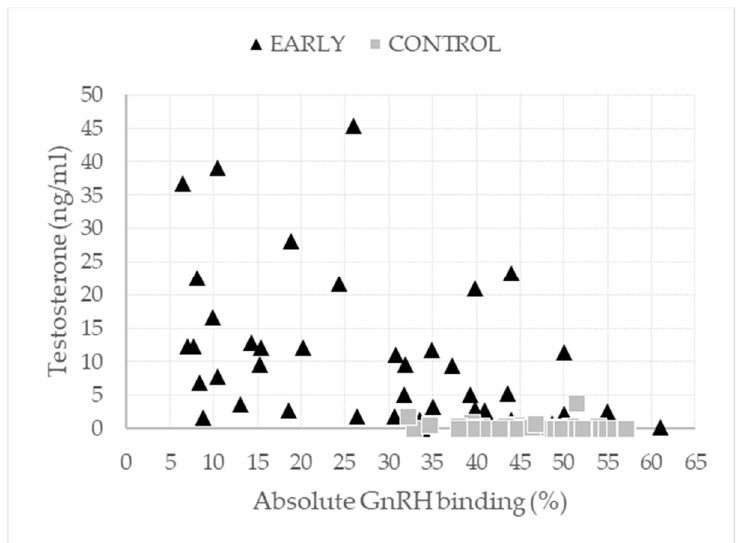
Figure 5. Testosterone levels and gonadotropin-releasing hormone (GnRH) binding according to the immunization scheme.